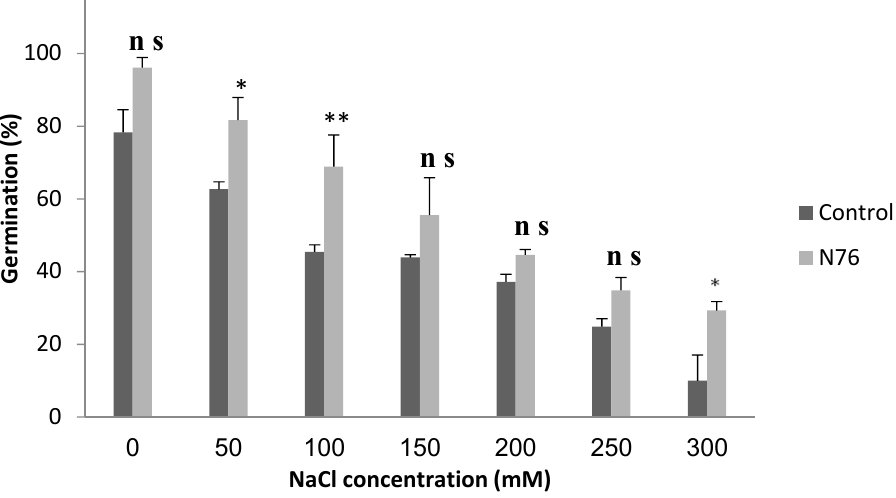
Figure 2. Effect of P. azotoformans on wheat seed germination under different NaCl concentrations. ns: no significant difference; *: significant difference ( p < 0.05); **: significant difference ( p < 0.005).